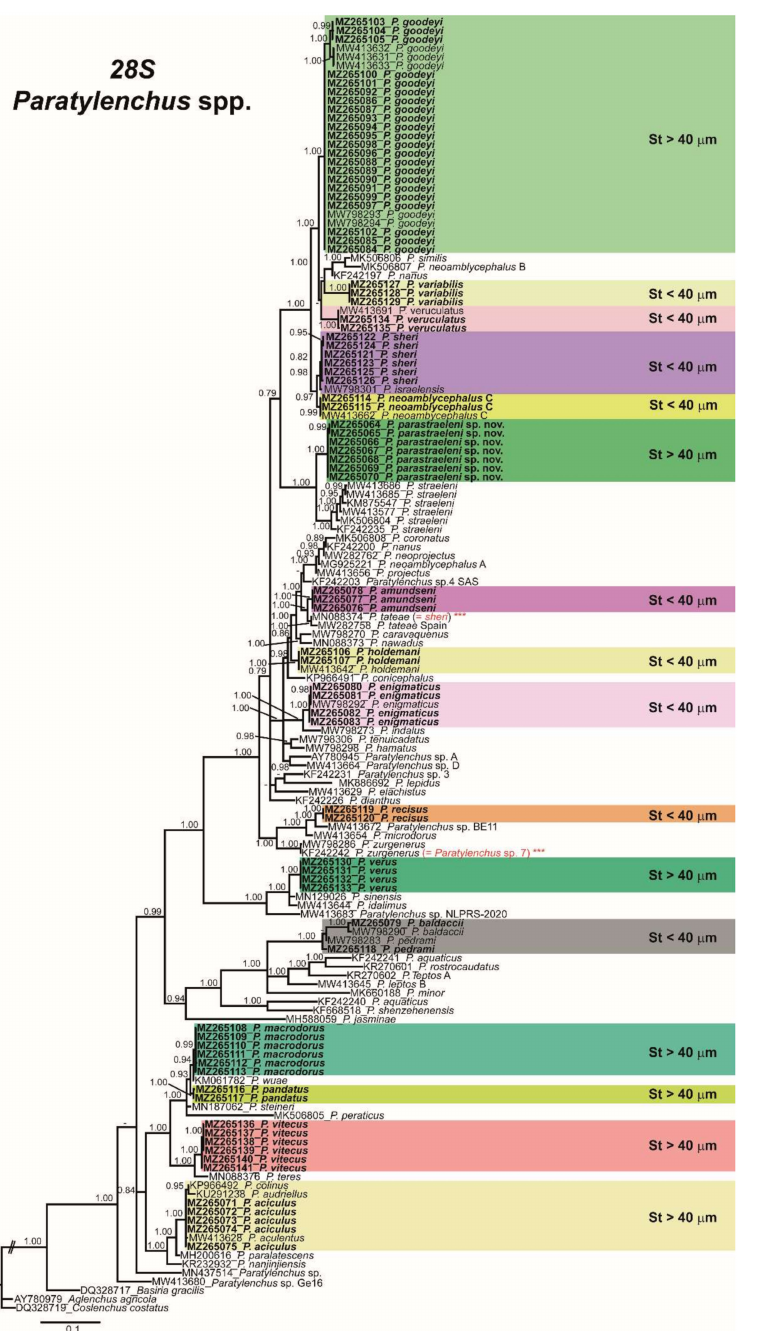
Figure 16. Phylogenetic relationships within the genus Paratylenchus . Bayesian 50% majority rule consensus tree as inferred from D2-D3 expansion domains of the 28S rRNA sequence alignment under the general time-reversible model of sequence evolution with correction for invariable sites and a gamma-shaped distribution (GTR + I + G). Posterior probabilities of more than 0.70 are given for appropriate clades. Newly obtained sequences in this study are shown in bold. The scale bar indicates expected changes per site. *** Red font names refer to the previous consideration in